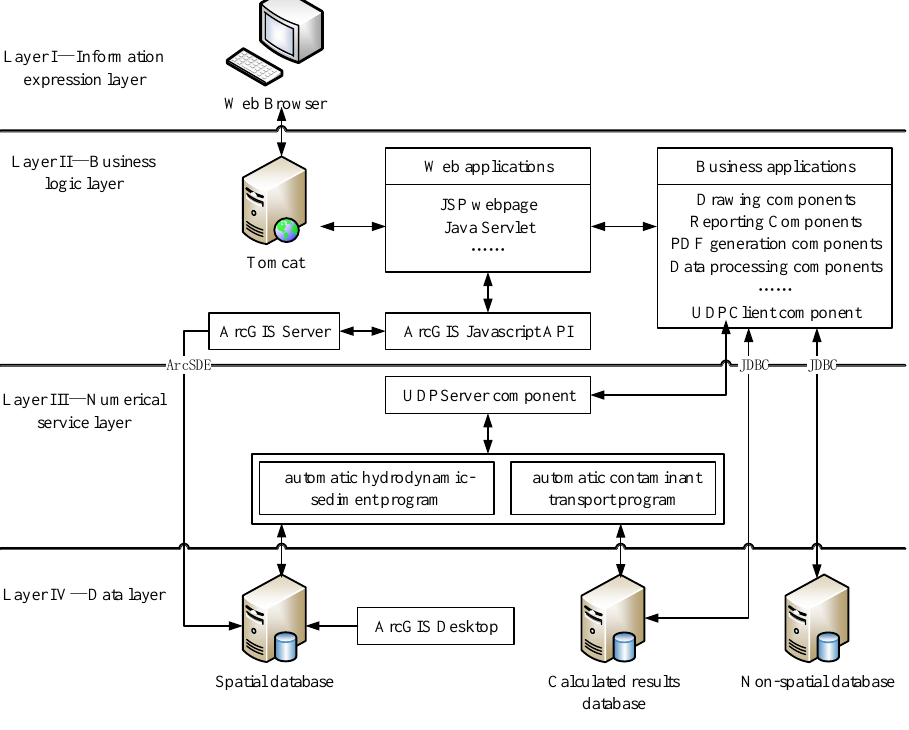
Figure 2. CSRU-DSS structure map.